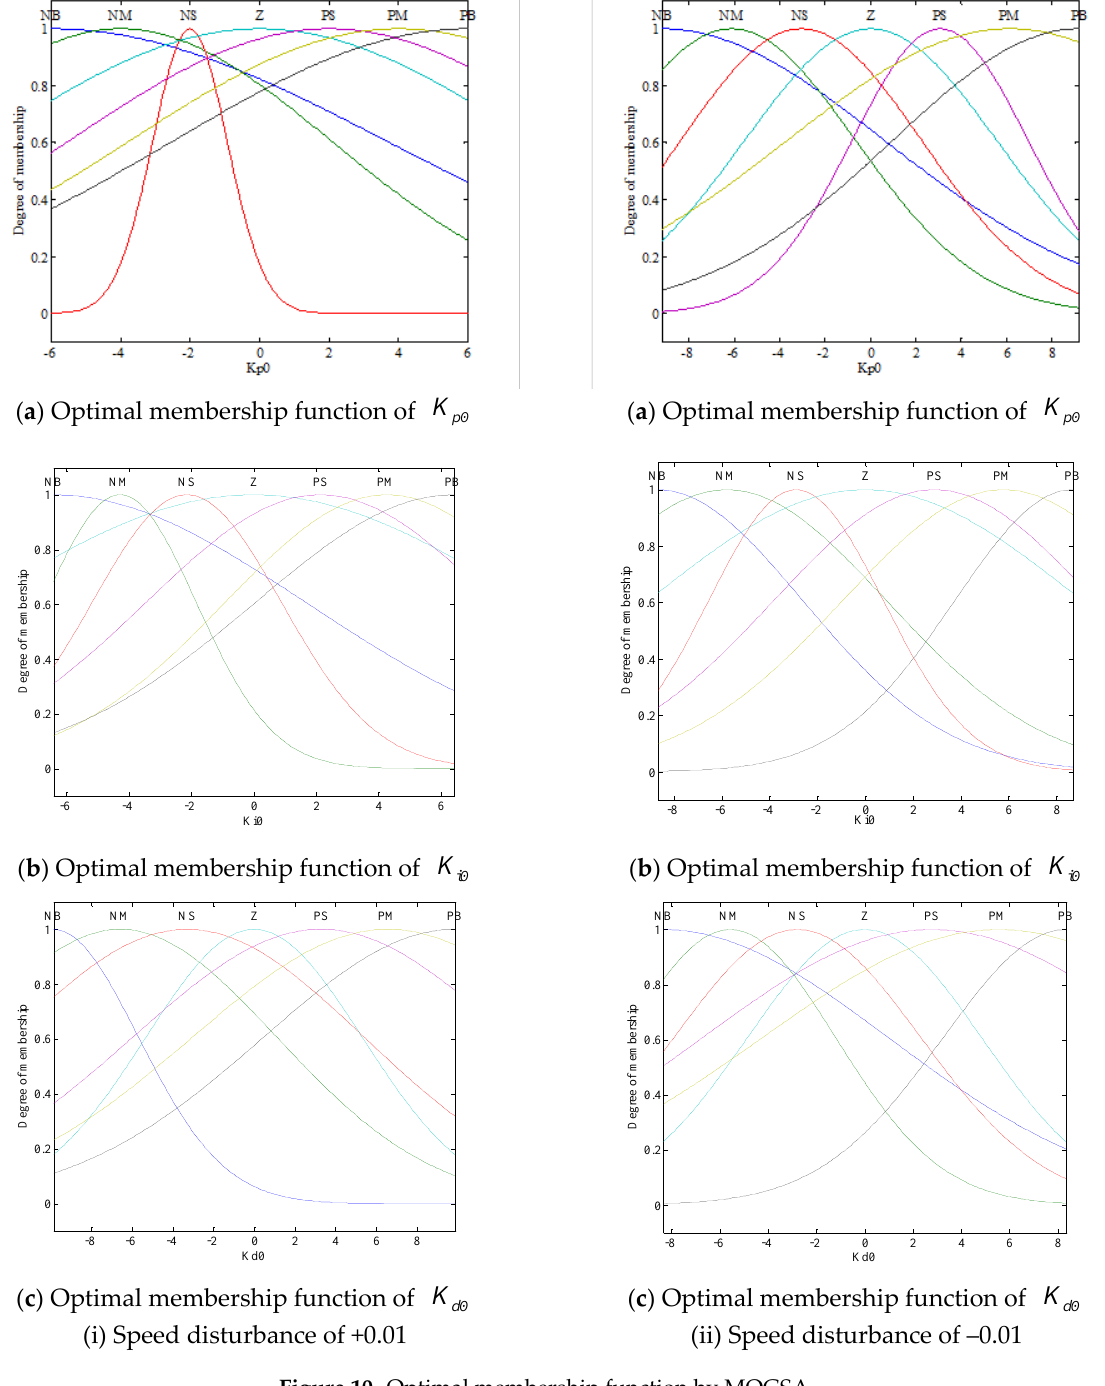
Figure 10. Optimal membership function by MOGSA.